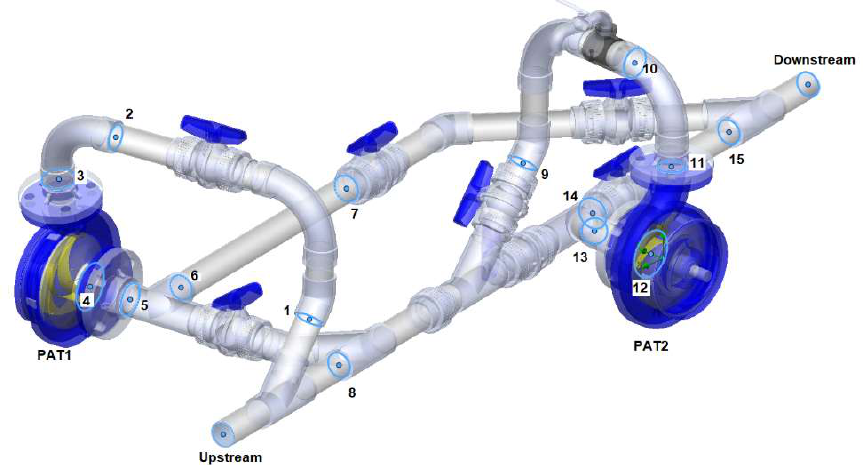
Figure 14. Location of monitor points in the control volume between inlet and outlet of PATs.